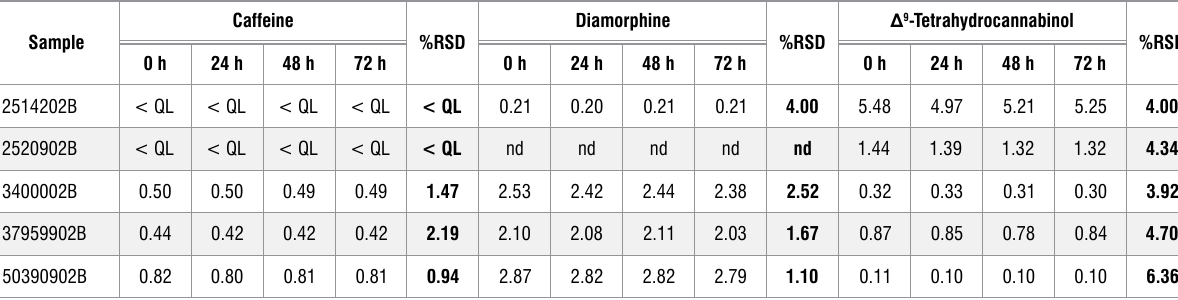
Concentration of actual street nyaope samples (mg/mL x 1000)